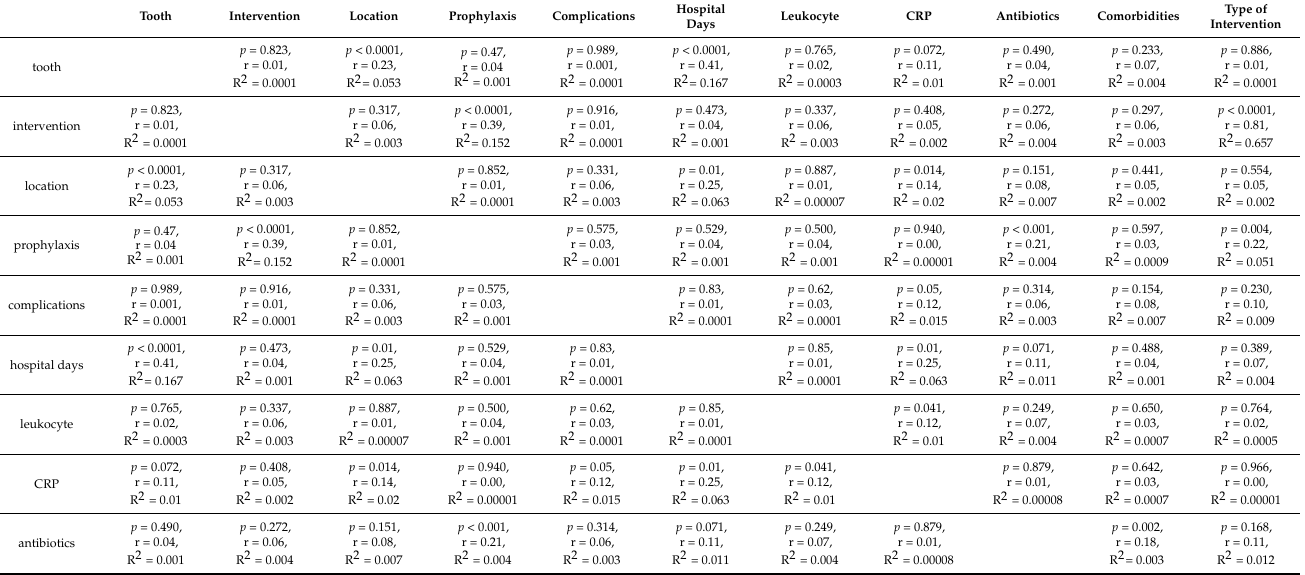
Figure 1. Distribution regarding causative tooth ( A ), abscess localization ( B ), and treatment modality ( C ) in adult patients with severe odontogenic abscess. Association between different clinical parameters (Table 2); a significant association was found between the occurrence of complications and hospitalization days ( p = 0.83, r = 0.01, R 2 = 0.0001) and the increase in CRP levels ( p = 0.05, r = 0.12, R 2 = 0.015), WBC count increase ( p = 0.62, r = 0.03, R 2 = 0.0001), antibiotics ( p = 0.31, r = 0.06, R 2 = 0.003), and comorbidities ( p = 0.154, r = 0.08, R 2 = 0.007) showed no association. In addition, hospital days showed a significant association with the increase in CRP level ( p = 0.01, r = 0.25, R 2 = 0.063), in contrast to the increase in WBC count ( p = 0.85, r = 0.01, R 2 = 0.0001) and antibiotics ( p = 0.07, r = 0.11, R 2 = 0.01). Table 2. Association between analyzed clinical